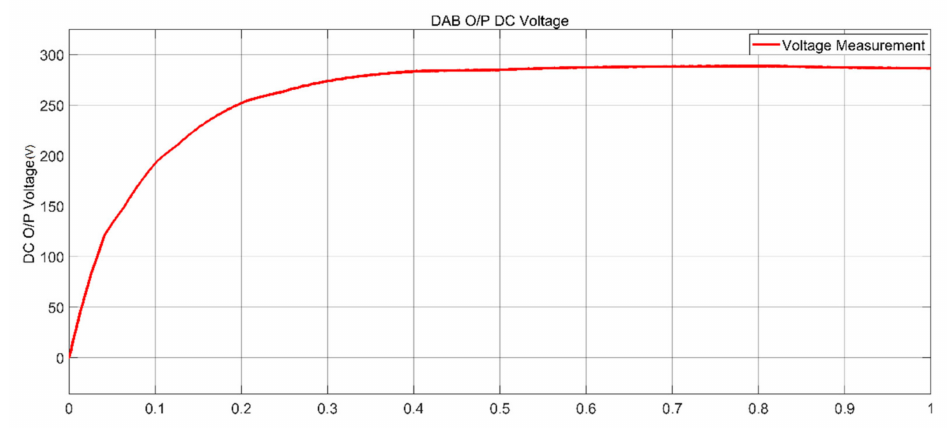
Figure 20. DC output voltage of DAB converter. Table 5. Parameters for the proposed scheme.